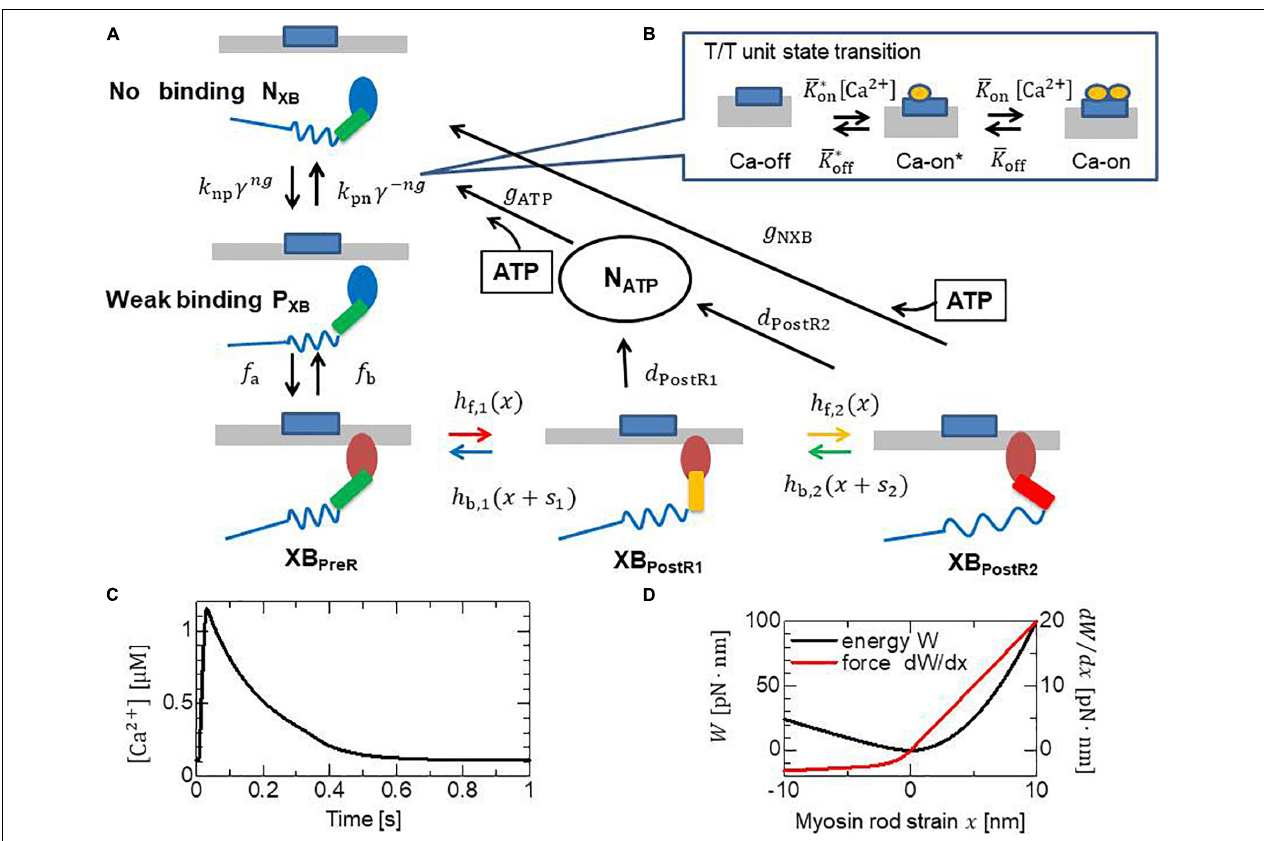
FIGURE 2 | State transition Monte Carlo model of (A) the myosin molecule and (B) the T/T unit. The myosin molecules in either the N XB or P XB states are assumed to be detached. The rate constants in the T/T unit state transition are affected by the states of the myosin heads (MHs) below it. The rate constant factors k np and k pn between N XB and P XB are affected by the state of the T/T unit above it. ng is an integer that takes the values 0, 1, or 2, according to the number of neighboring MHs attached. γ = 40 was adopted to model the co-operativity of the MHs. The forward transitions from XB PreR to XB PostRs via XB PostR 1 are called ‘power strokes,’ whereas the back transitions are called ‘reverse strokes.’ The MHs connected to the extremely strained myosin rods are detached to N ATP . (C) The typical transient of [Ca 2 + ] applied to the T/T unit state transition in panel (B) . (D) The strain energy W of the myosin rod and the non-linear force dW / dx